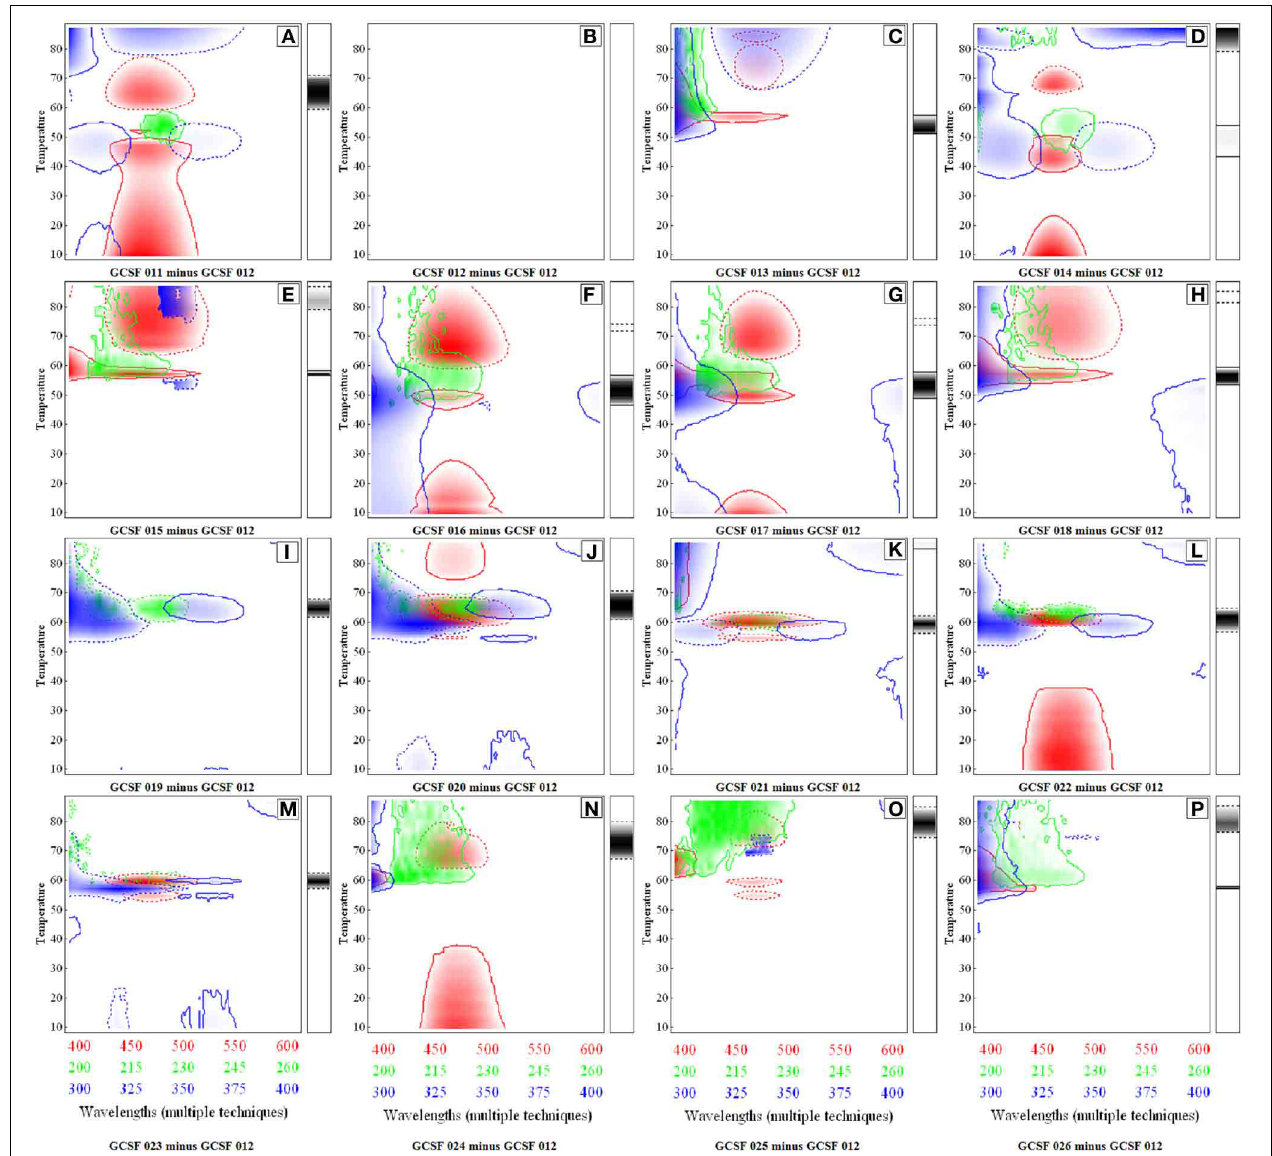
FIGURE 5 | Comparative Signature Diagrams (CSDs) for different formulations of Granulocyte Colony Stimulating Factor (GCSF). Formulation GCSF 12 was used as the control condition. Each diagram (A–P) represents the comparison of a particular formulation with GCSF 12. Red, blue, and green colors represent differences in spectra of ANS